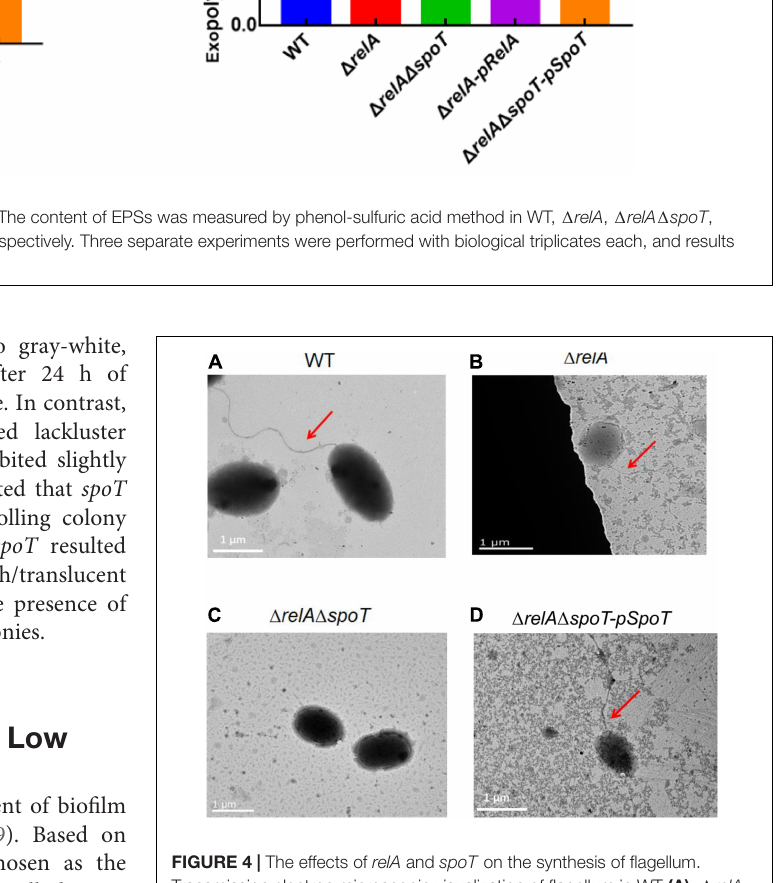
and supplementation of the spoT gene in (cid:49) relA (cid:49) spoT